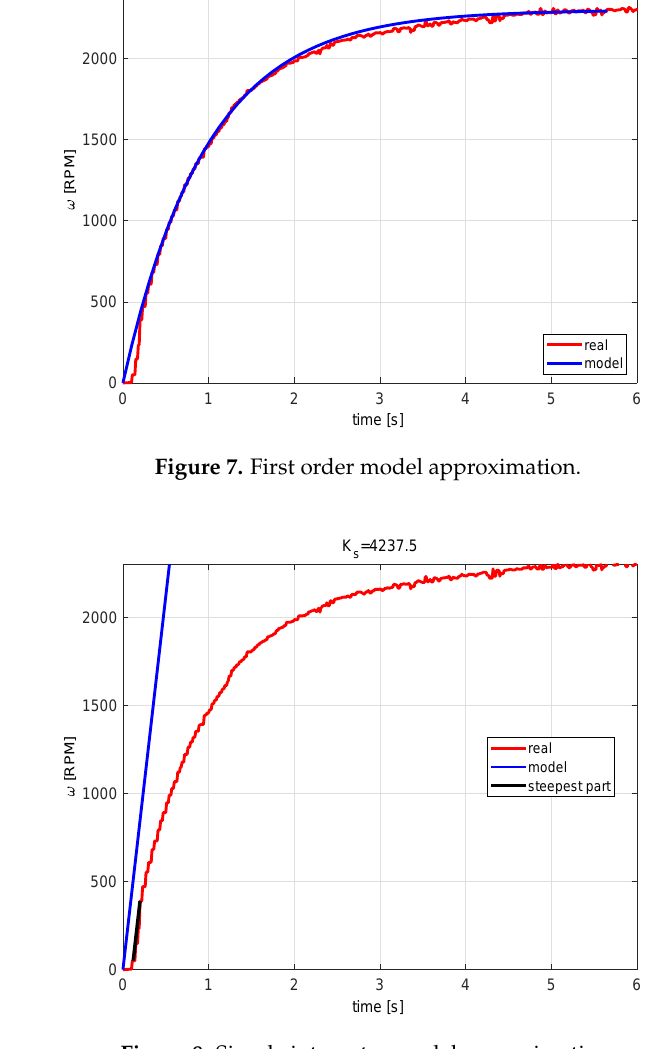
Figure 8. Simple integrator model